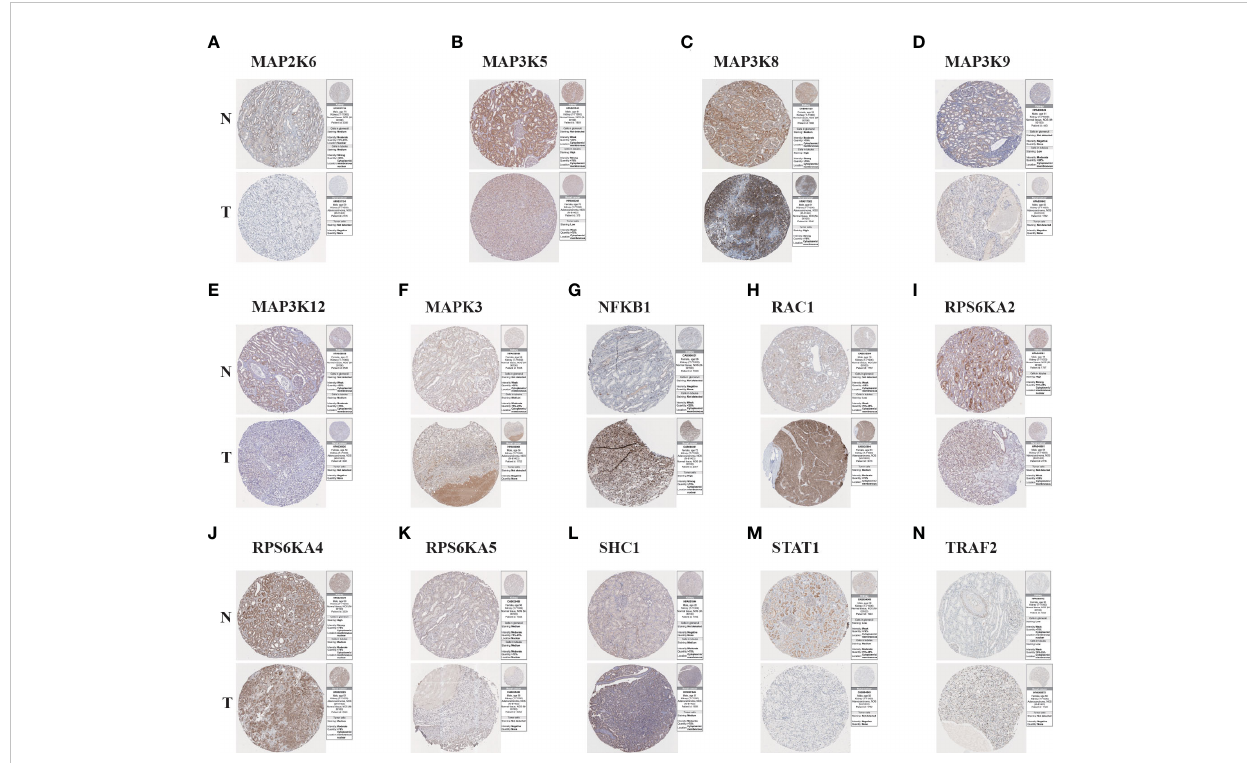
FIGURE 6 The Results of immunohistochemistry. (A – N) The Human Protein Atlas database was used to verify the proteins ’ differential expression of 14 model genes (MAP2K6, MAP3K5, MAP3K8, MAP3K9, MAP3K12, MAPK3, NFKB1, RAC1, RPS6KA2, RPS6KA4, RPS6KA5, SHC1, STAT1, TRAF2) in KIRC tumor tissues (T) and adjacent normal tissues